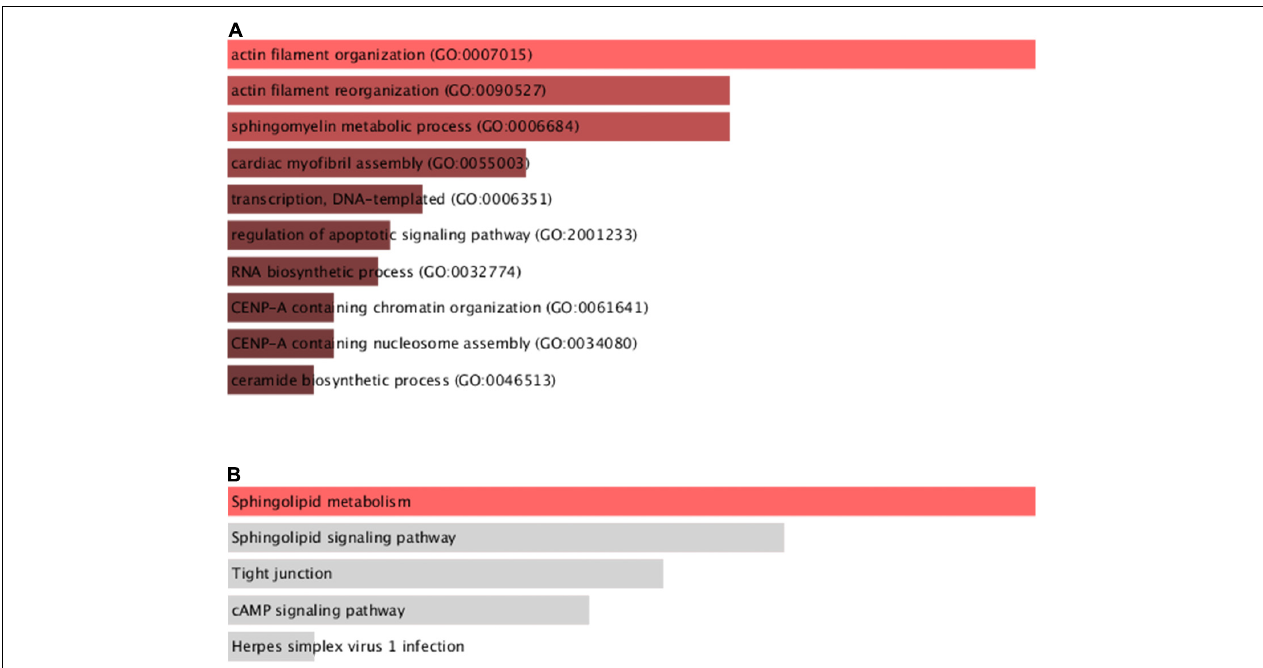
FIGURE 6 | Functional enrichment analysis of differentially expressed genes between subgroups. (A) GO function analysis of differential genes among four subgroups. (B) KEGG pathway analysis of differential genes among four